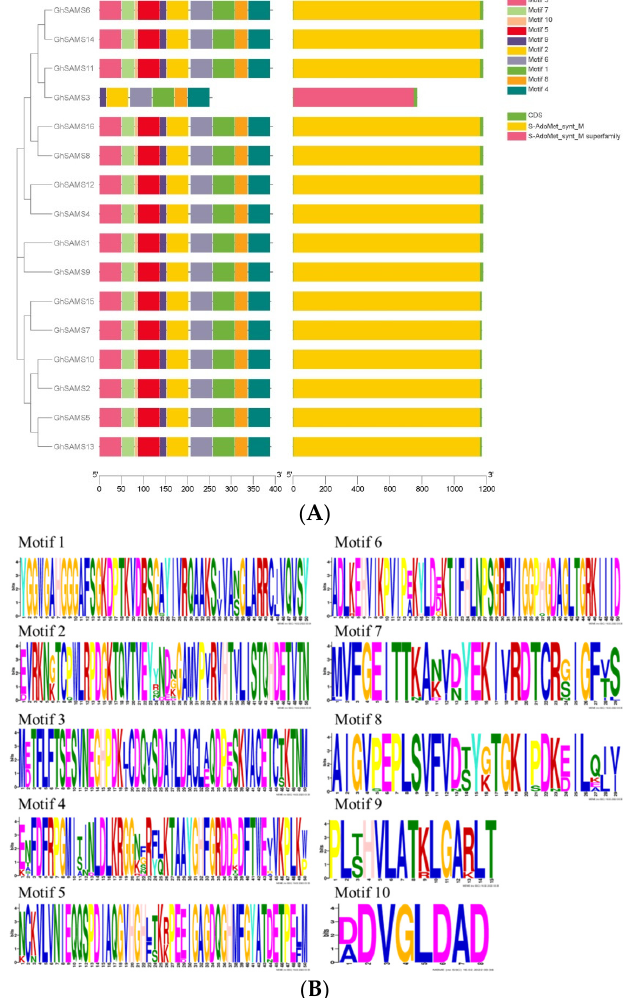
Figure 2. Sequence conservation analysis of SAMS proteins: ( A ) Alignment of the conserved domains of SAMS proteins and genomic exon–intron structures in upland cotton. ( B ) Ten conserved motifs.